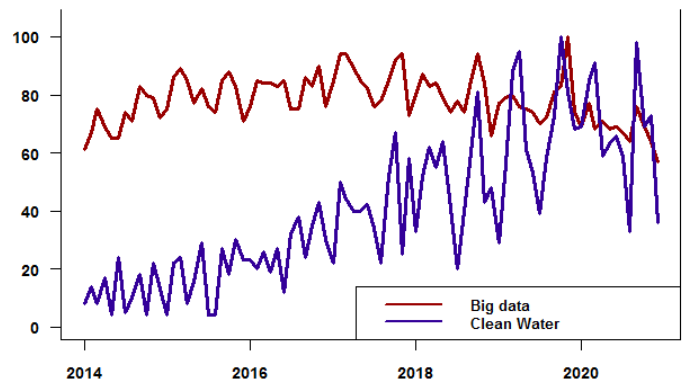
Figure 7. Big Data and SDG 6 global Google trends since